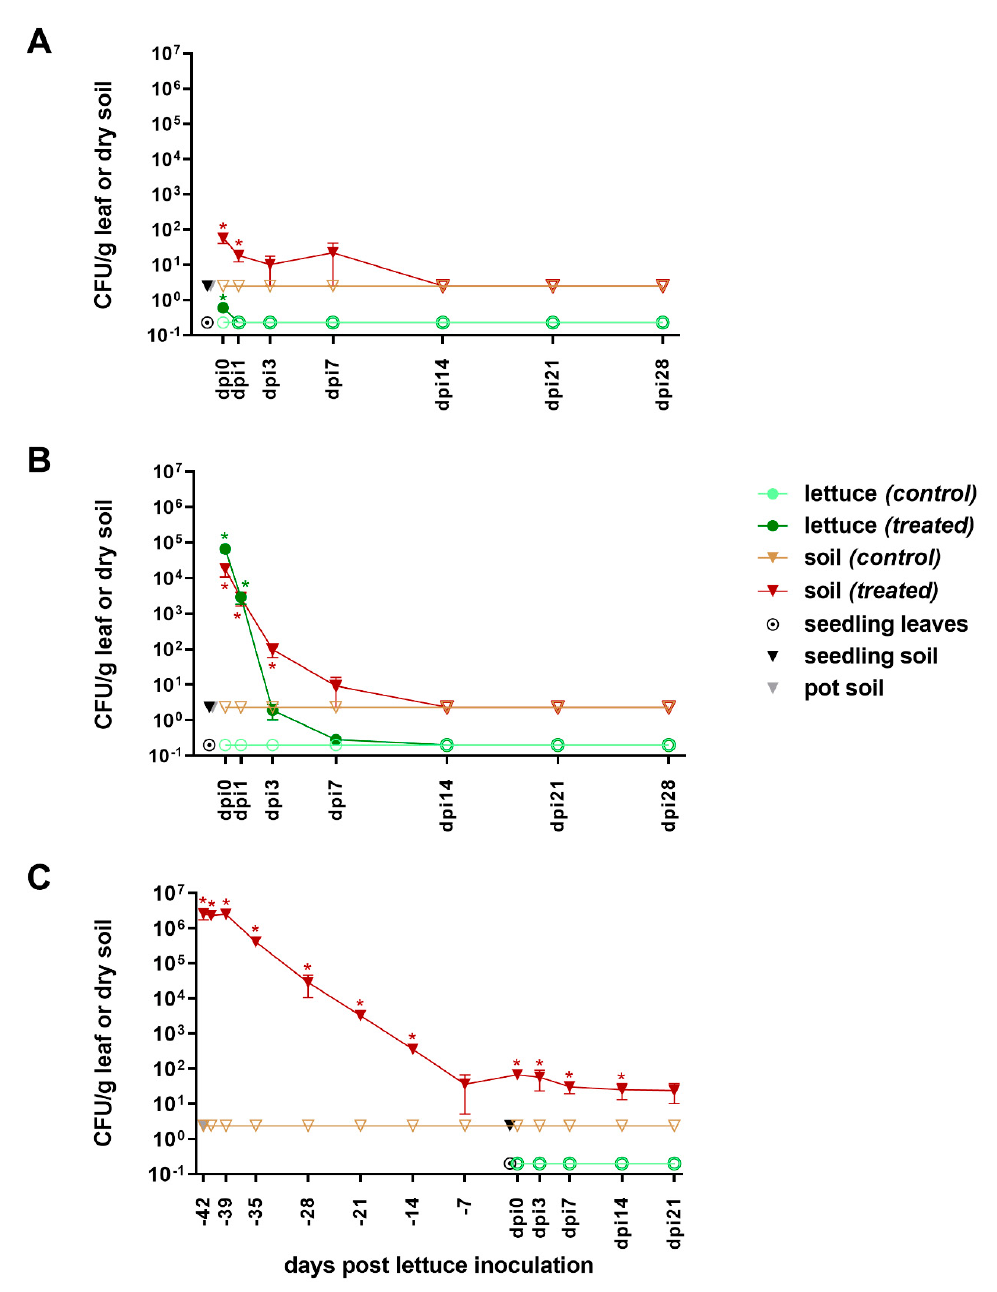
Figure 1. Survival of E. coli pEK499 in soil ( ‐ ▼ ‐ ) and lettuce ( ‐●‐ ) from its introduction until harvest. Low ‐ and high ‐ level contamination experiments via water ( A and B , respectively) and via manure ( C ) are shown. Empty symbols indicate values below the respective limit of detection. Error bars indicate standard error of the mean (SEM, n = 3). Significant differences between treatment and control ( p < 0.05) are marked with an asterisk. A detailed view of panel A is provided in Figure A1.